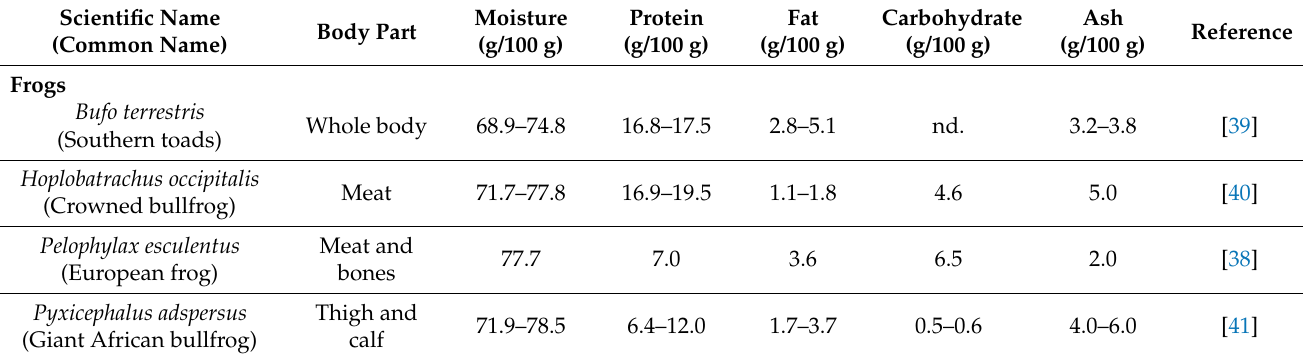
Table 1. Nutritional composition of common species of edible